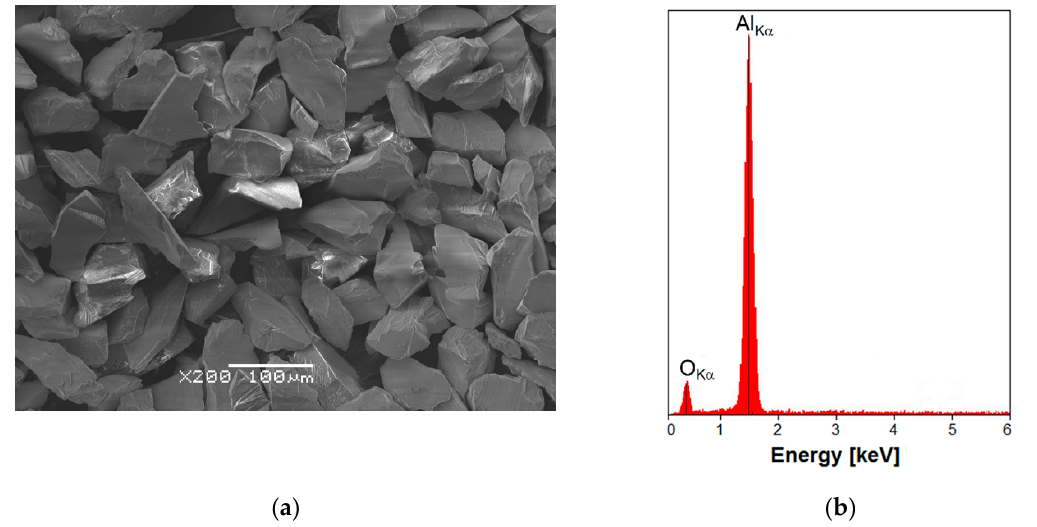
Figure 1. ( a ) SEM image of white Al 2 O 3 particles used for sandblasting; ( b ) EDS spectrum of Al 2 O 3 .